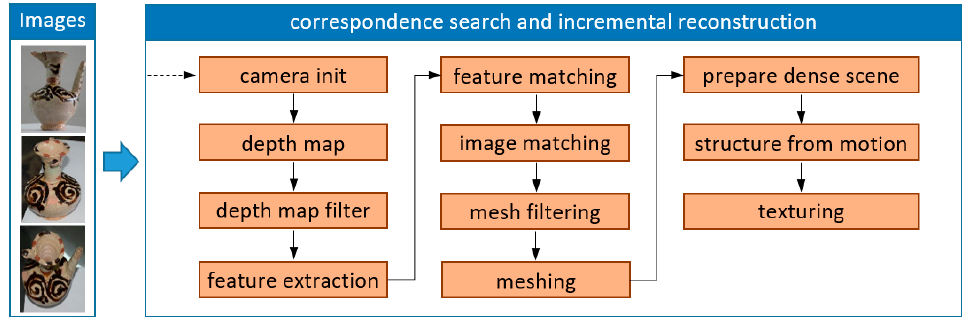
Figure 6. Stages of data processing in the SfM method.